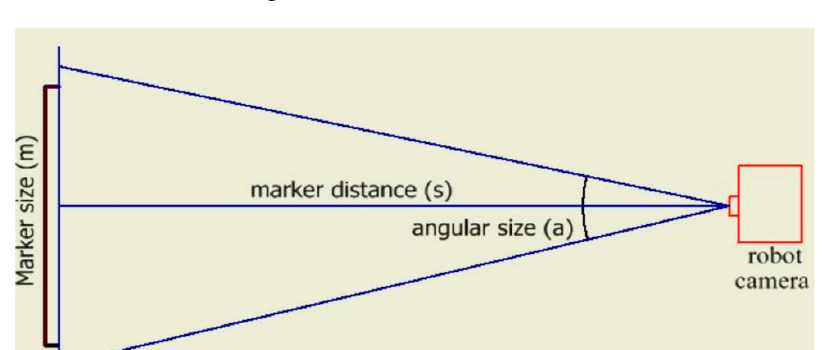
Figure 10. NAO mark dimension. Sensors 2019 , 19 , x FOR PEER REVIEW